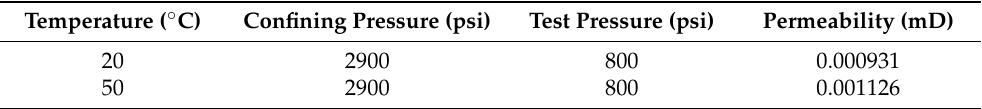
Table 2. Moisture content of the shale samples at room temperature.